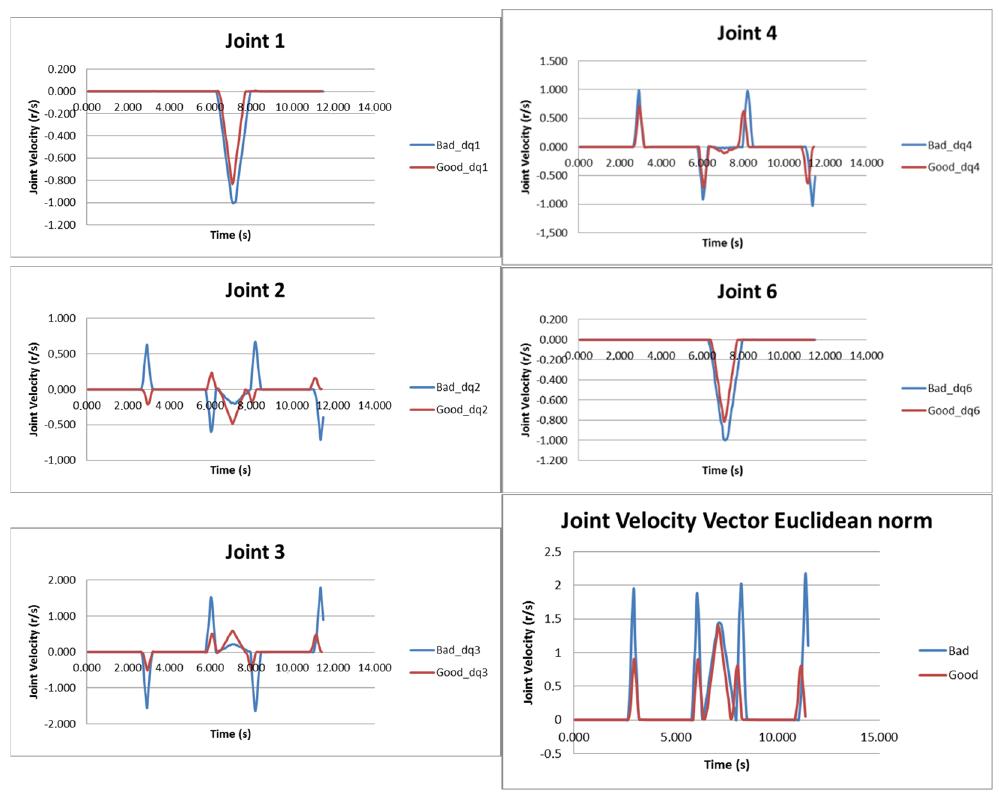
Figure 10. Joint velocities for the optimal and “bad” placement of the pick and place task for the cylindrical object.